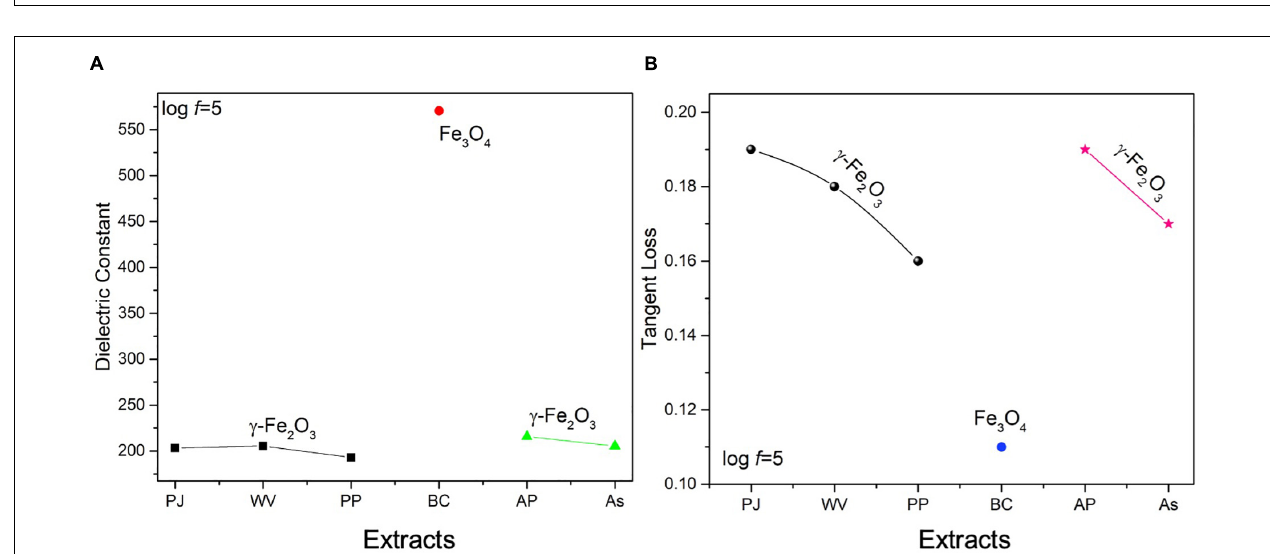
FIGURE 5 | Variation in (A) dielectric constant, (B) tangent loss of IONPs at log f = 5 FTIR, and UV-visible analysis of green-synthesized IONPs.